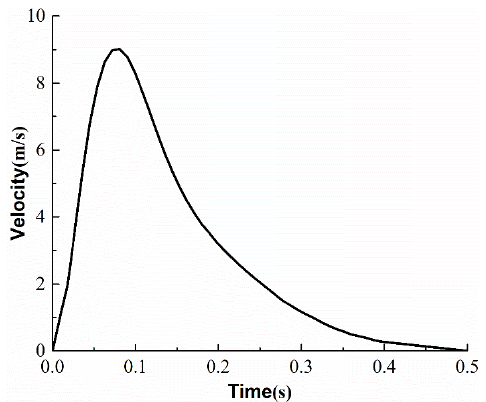
Figure 4. Flow velocity of a single cough with respect to time.